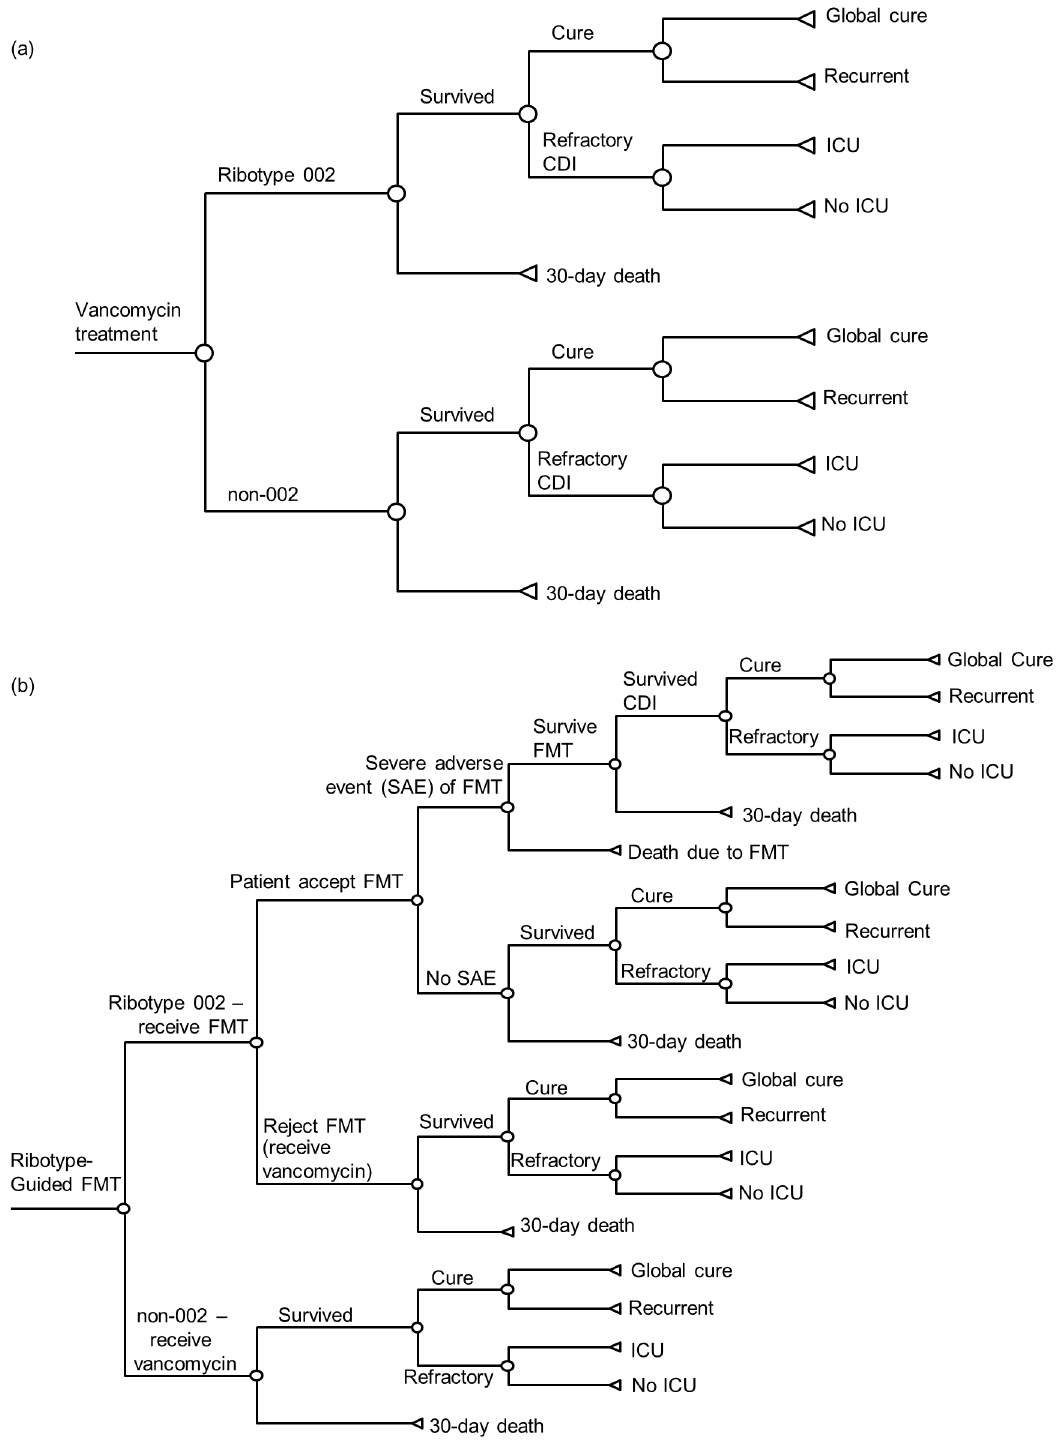
Fig 1. Vancomycin treatment arm (a) and ribotype-guided FMT arm (b) of decision-analytic model for patients with severe CDI. CDI: Clostridium difficile infection; FMT: fecal microbiota transplantation; ICU: intensive care unit.